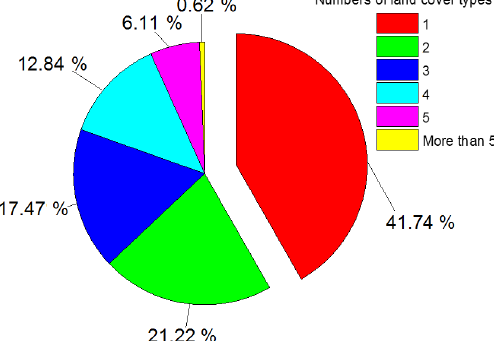
Table 2. Details of the Heihe River basin (HRB) in situ